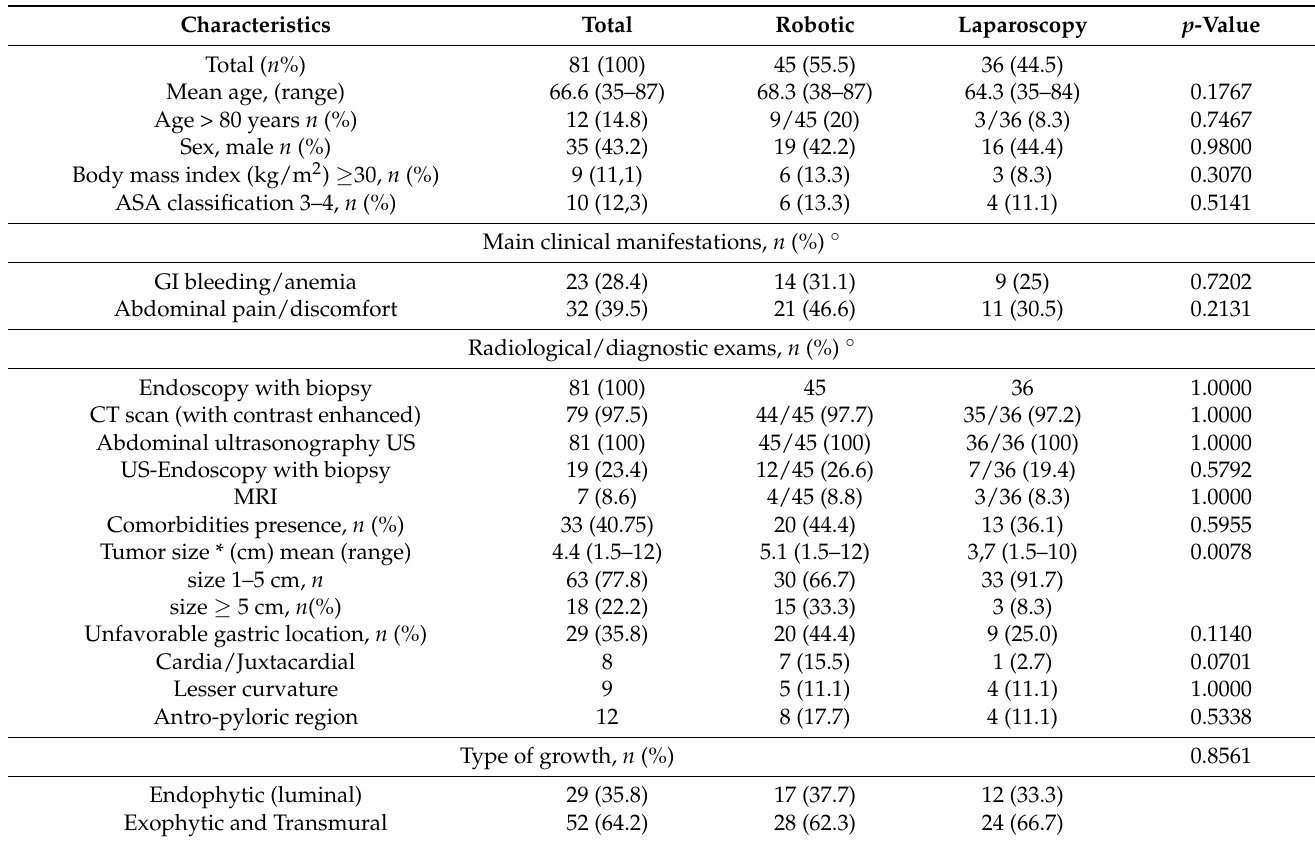
Table 2. Demographics and clinico-pathologic data of gastric GIST treated in the two series Robotic surgery (RS) and Laparoscopy (LS).